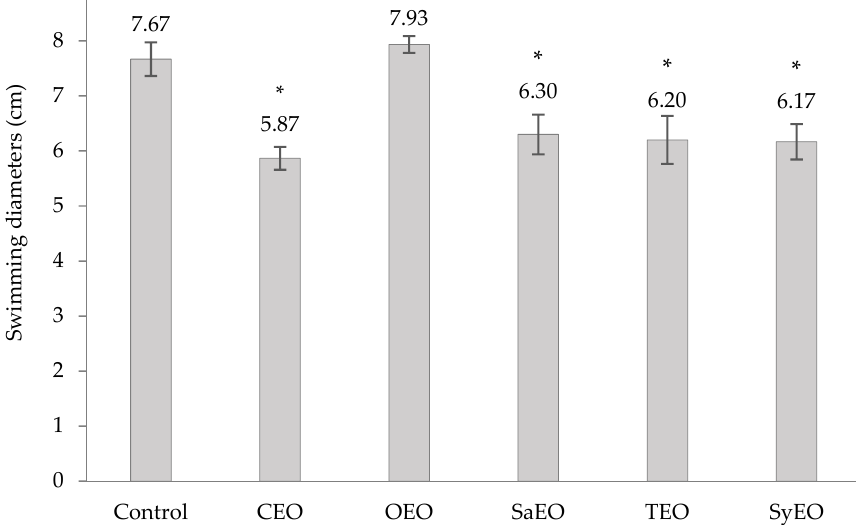
Figure 3. Effect of EOs on the swimming motility of Salmonella sv. Typhimurium. EOs are tested at concentrations equivalent to those applied to Caenorhabditis elegans during the colonization assay, i.e., 50 µ g/mL for CEO, OEO and SaEO, 100 µ g/mL for TEO, and 150 µ g/mL for SyEO. Ethanol, applied at a final concentration of 1%, was used as control. Swimming diameters (cm) are means ± SD ( n = 3). * p <